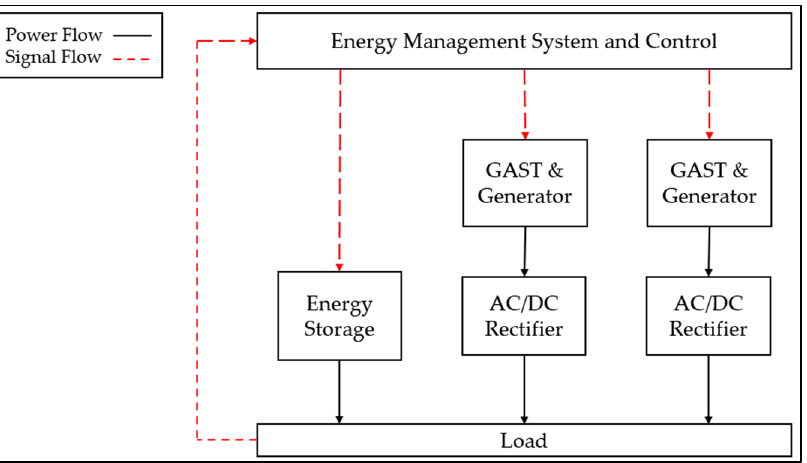
Figure 6. Hybrid LNG–electric system using